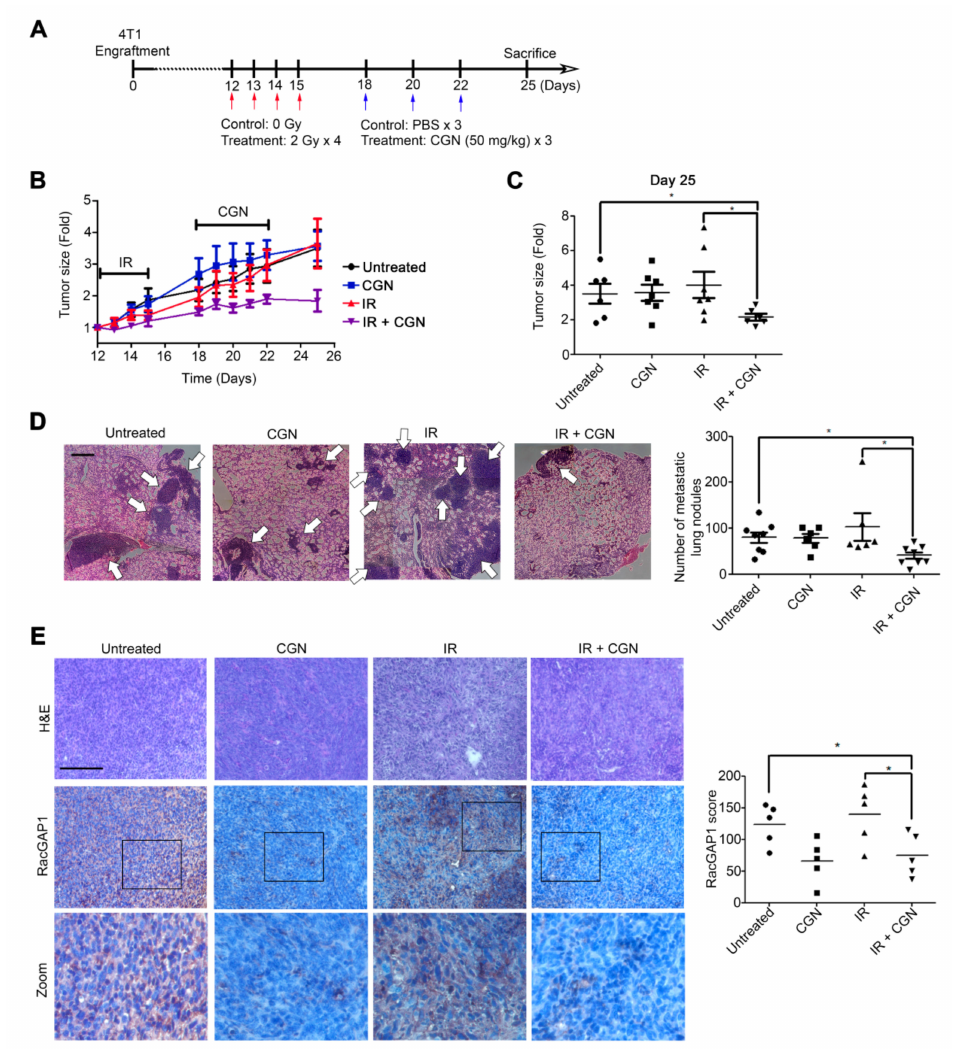
Figure 6. Radiation followed by CGN treatment decreases tumor size and metastasis in a 4T1 mouse xenograft model. ( A ) Treatment schedule of each group. Mouse 4T1 cells were injected into Balb / c mice ( n = 6–7 in each group). ( B ) 4T1 tumor sizes were measured and normalized to size at day 12 in each group. ( C ) Relative tumor size for each group was measured on Day 25. Scatter plot; mean ± SE. *, p < 0.05. ( D ) Representative H&E images of lung sections. Bar, 500 µ m. Arrow, metastatic lung nodules. The number of metastatic lung nodules was counted (right panel). Scatter plot; mean ± SE. *, p < 0.05. ( E ) Sections from 4T1 tumors were subjected to IHC staining with antibodies against RacGAP1. Bar, 100 µ m. RacGAP1 expression level was determined by scoring, as described in the methods (right panel). Scatter plot; bars, mean ( n = 5). *, p <